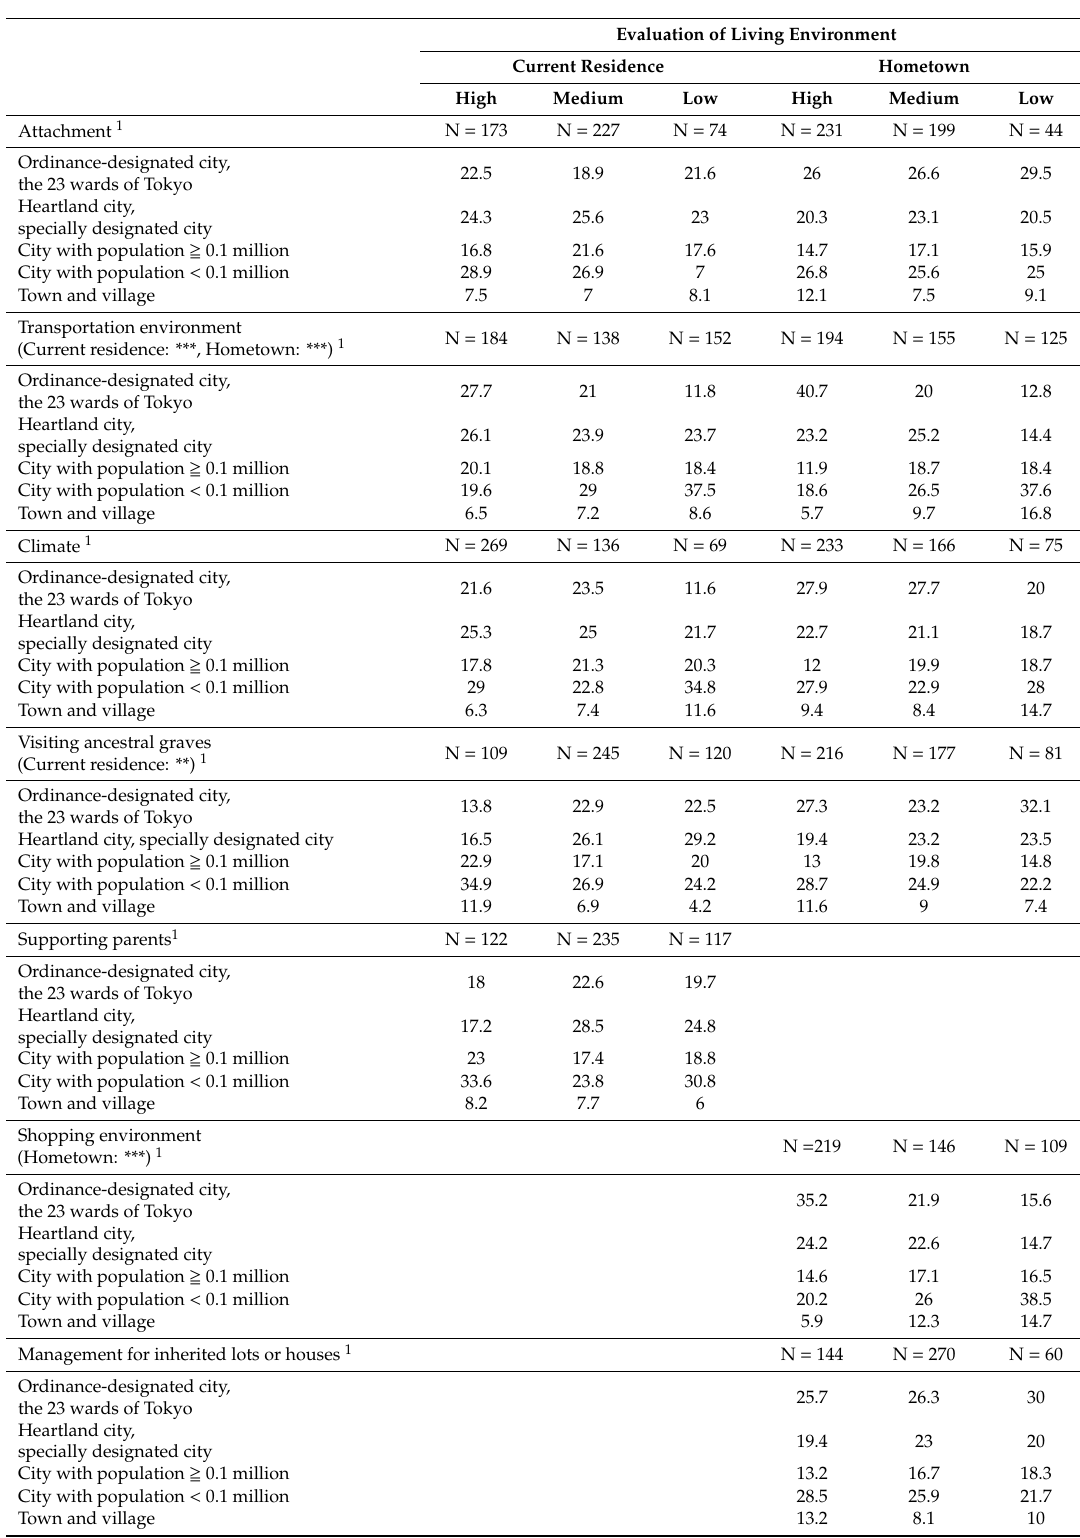
Table 8. Relationship between city size and the evaluation of living